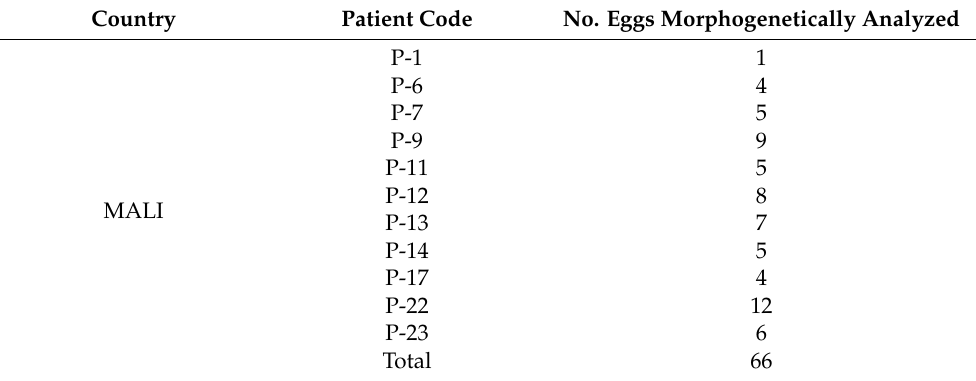
Table 1. Number of eggs phenotyped and genotyped for each of the 20 patients (P) included in this study, according to their country of